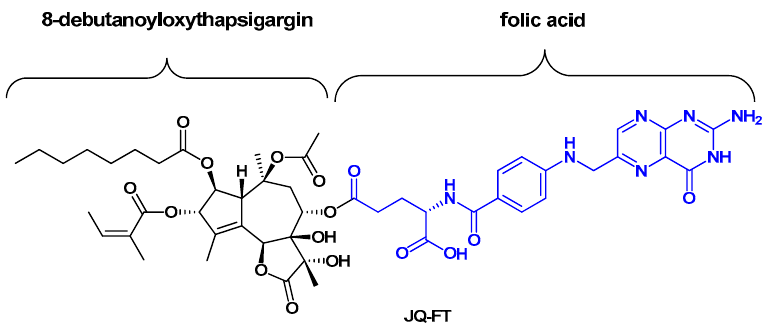
Figure 5. The structure of the Tg-folate prodrug, JQ-FT.